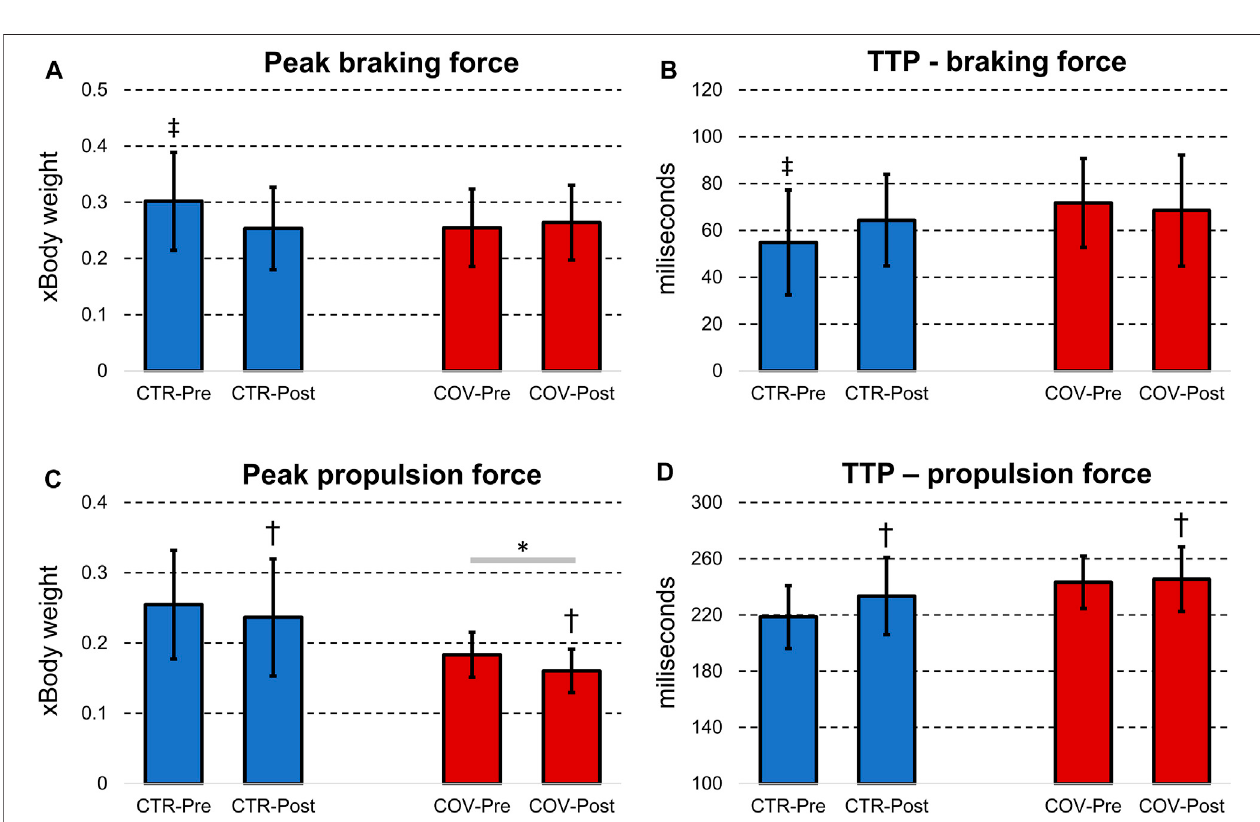
FIGURE3| Meansandstandarddeviationsforpeakbrakingforce (A) ,time-to-peak(TTP)brakingforce (B) ,peakpropulsionforce (C) andtime-to-peakpropulsion force (D) from the control (CTR, blue bars) and hospitalized COVID-19 runners (COV, red bars) before (Pre) and after the fatigue protocol (Post). *denotes signi fi cant difference in relation to the CTR group ( p < 0.05); † denotes signi fi cant difference in relation to Pre from the same group ( p < 0.05); ‡ denotes signi fi cant difference in relation to CTR-Post and the COV group (Pre- and Post-fatigue) ( p < 0.05).